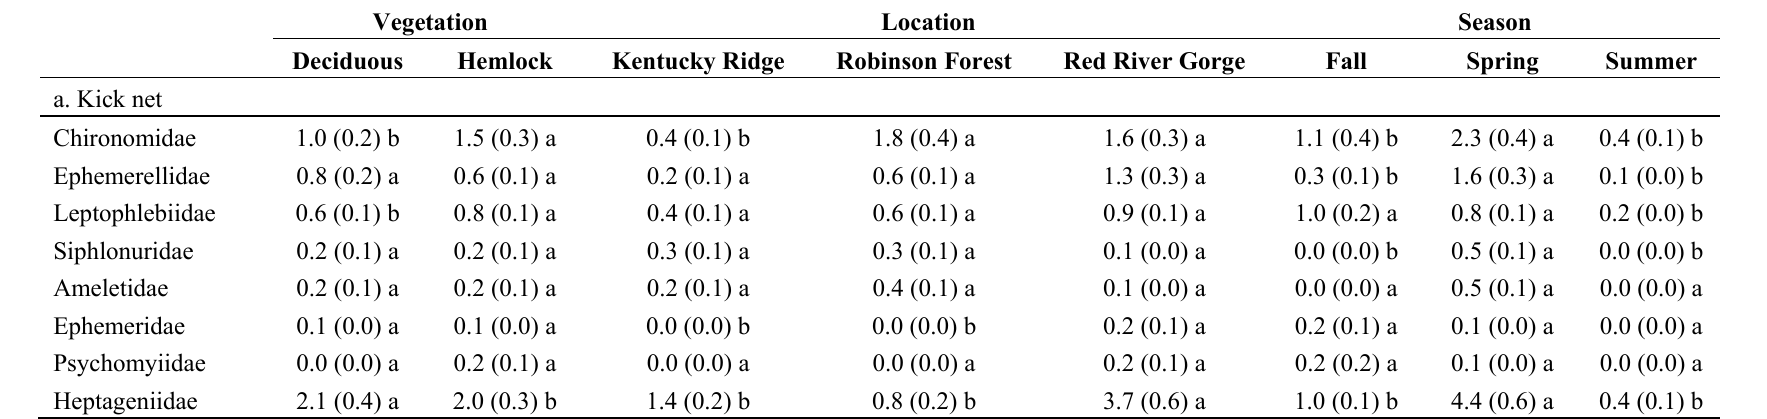
Table 2. Abundance (mean (S.E.)) of benthic collectors and grazers collected in (a) kick nets; (b) Surber; and (c) Hester-Dendy Samplers from headwater streams with eastern hemlock or deciduous dominated riparian vegetation across two years in Kentucky (USA). For location, vegetation, and season, means within rows followed by the same letter are not significantly different (α =